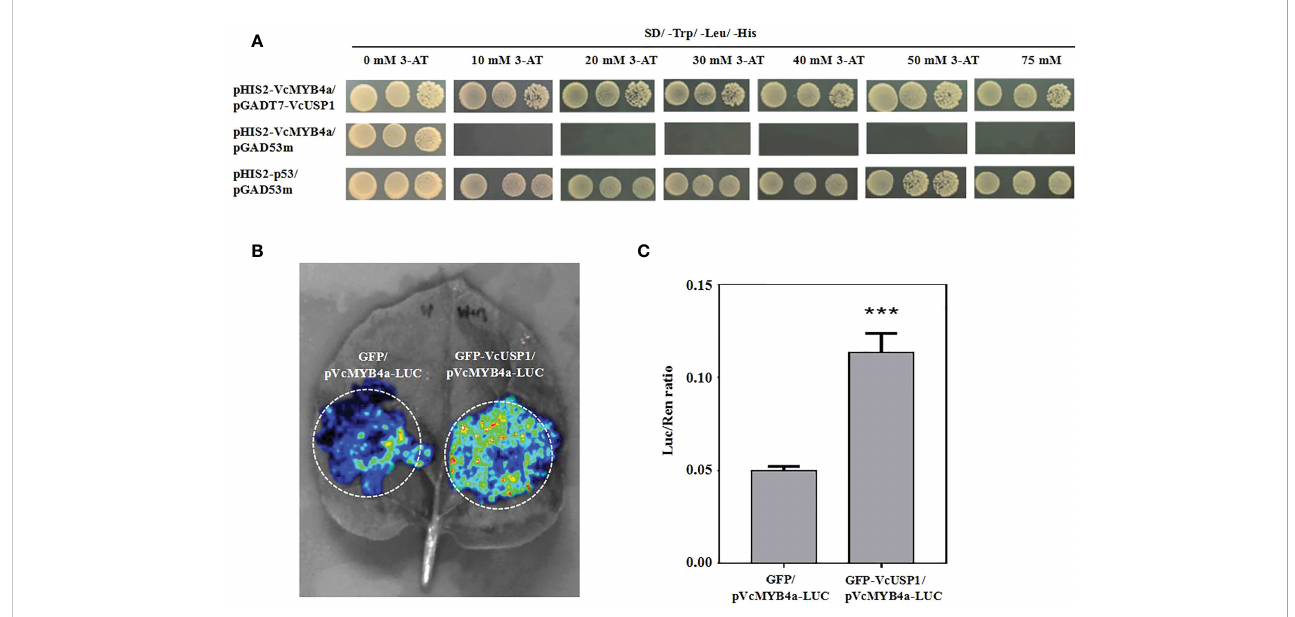
FIGURE 6 The VcUSP1 protein binds to upstream sequences of VcMYB4a . (A) Interaction of VcUSP1 with the VcMYB4a promoter in a yeast one-hybrid assay. pHIS2-VcMYB4a/pGAD53m was used as a negative control and pHIS2-p53/pGAD53m as a positive control. A series of 5-µL aliquots of 10 × diluted yeast cultures was grown on SD medium lacking tryptophan, leucine, and histidine (SD/ – Trp/ – Leu/ – His) and with different concentrations of 3-amino-1,2,4- triazole (3-AT) for 3 days at 30°C. (B) Interaction of VcUSP1 with the VcMYB4a promoter using dual luciferase complementation imaging assays in Nicotiana benthamiana leaves. GFP/pVcMYB4a-LUC was used as a negative control. (C) The ratio of Luc-to-Ren activity was measured for the dual luciferase assay. Error bars indicate the SD of three biological replicates. The asterisks indicate statistically signi fi cant differences by Tukey ’ s test (***Correlation signi fi cant at the 0.001